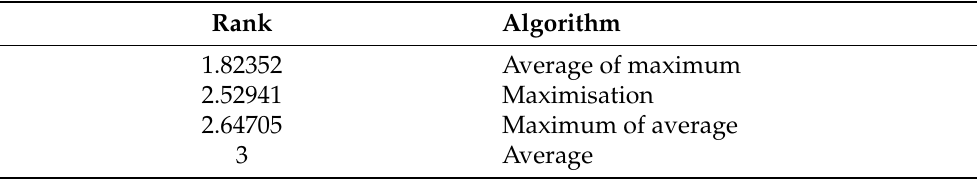
Table 6. Friedman results of the proposed methodology using different aggregation techniques for ROC.